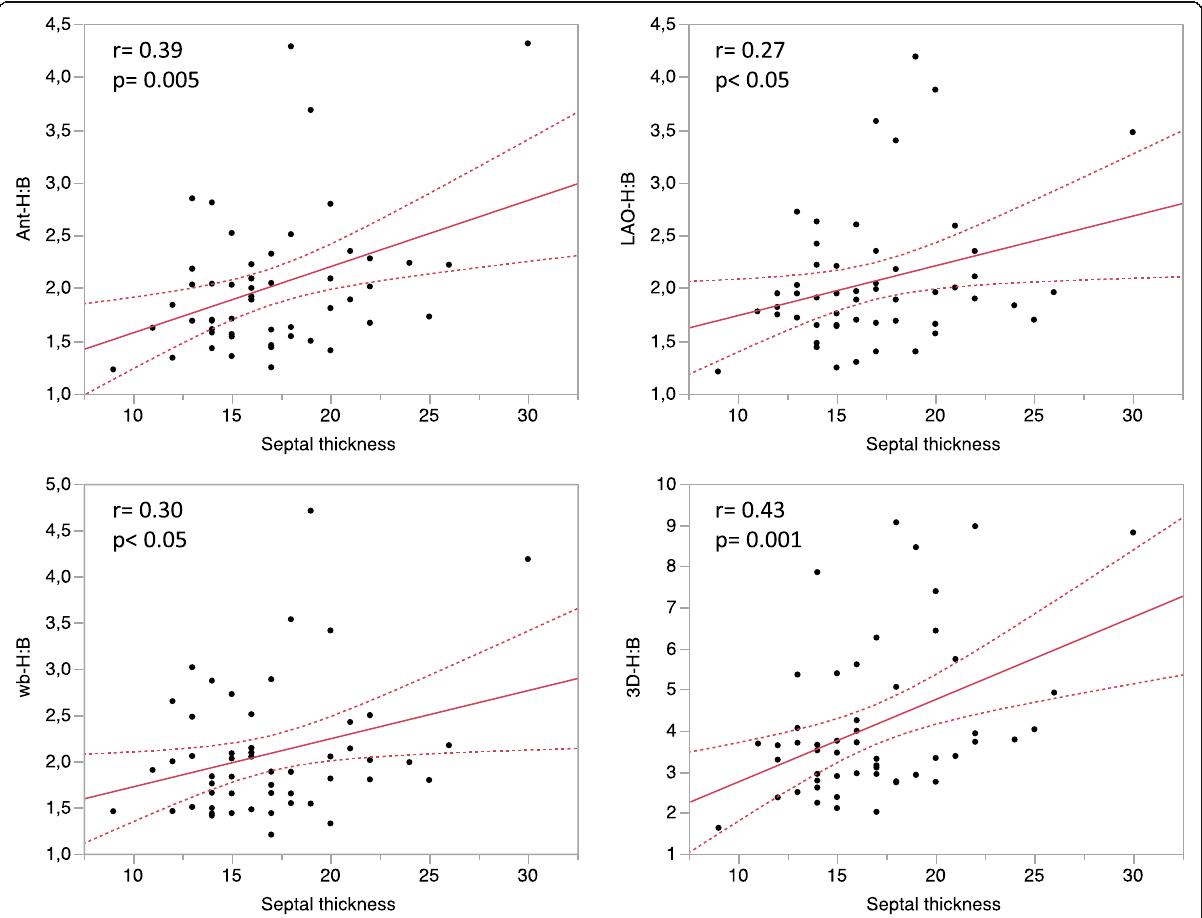
Fig. 2 Correlation of the heart-to-background (H:B) uptake ratio to the septal wall thickness. WB, whole-body H:B; Ant, anterior planogram H:B; LAO, left anterior oblique planogram H:B